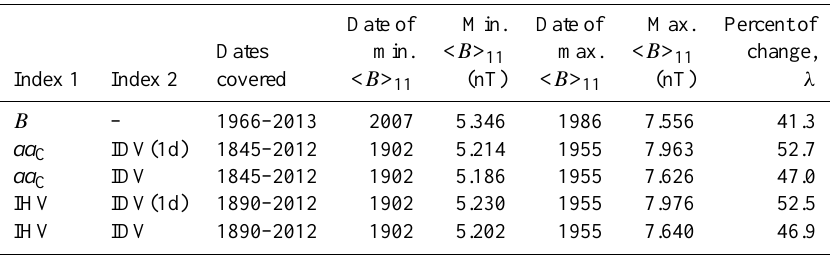
Table 4. Maximum and minimum of 11yr running means of annual near-Earth IMF estimates < B > 11 from the four combinations of geomag- netic activity indices and from in situ satellite observations (top row). The last column gives the percentage change, λ , between the minimum and the maximum. The first row is for in situ spacecraft